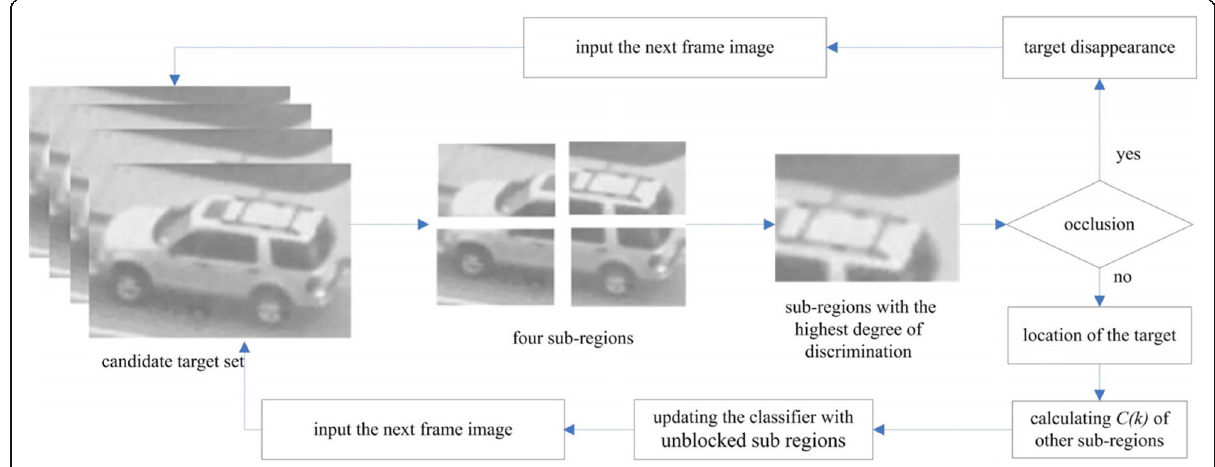
Fig. 4 Sub-regions partition and classifier